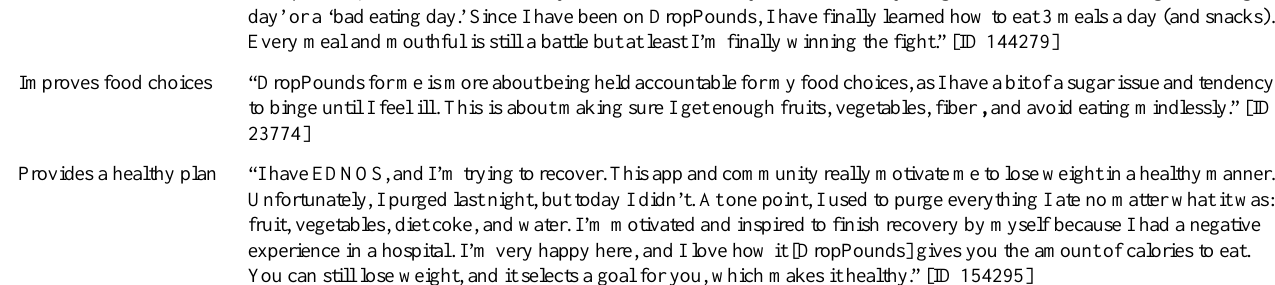
Table 3. Negative aspects of the app and example posts.